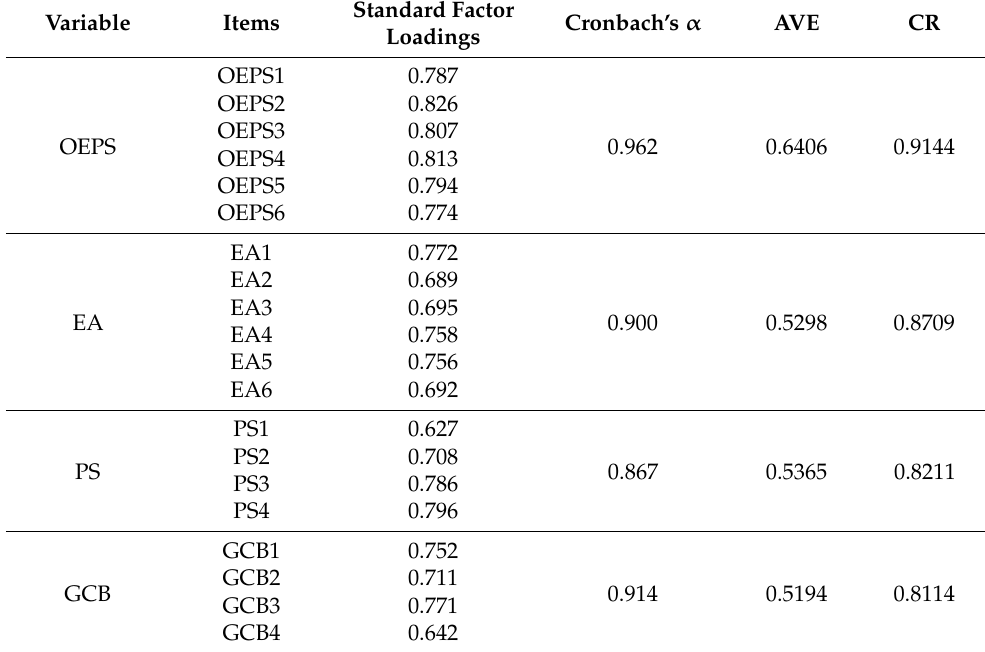
Table 2. The results of reliability and validity test of